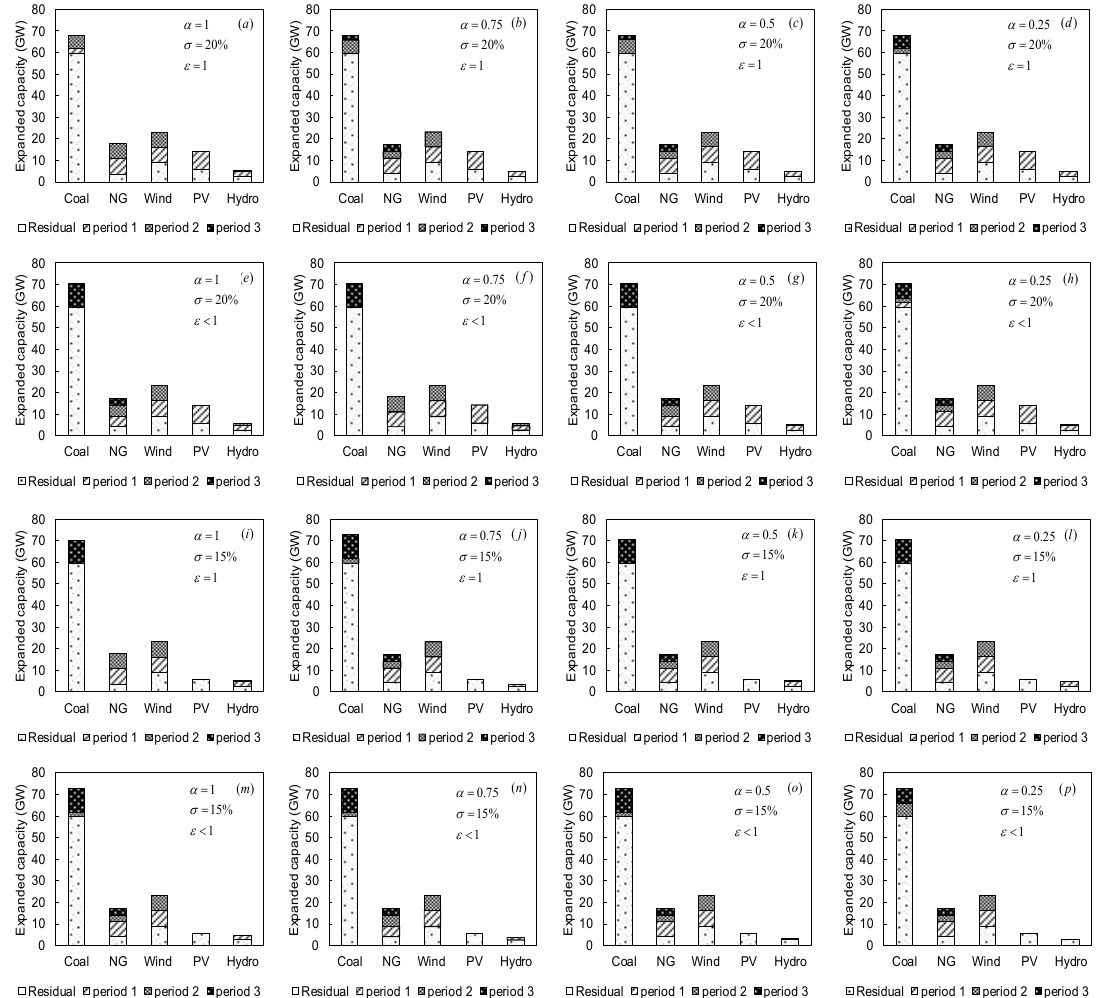
Figure 8. Capacity expansion schemes under di ff erent ε , σ values and α levels.